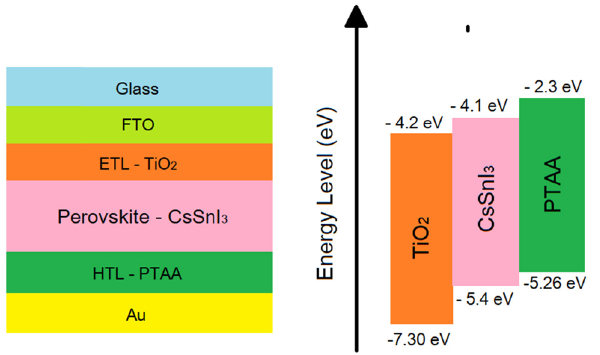
Figure 1: Schematic representation of the basic device.